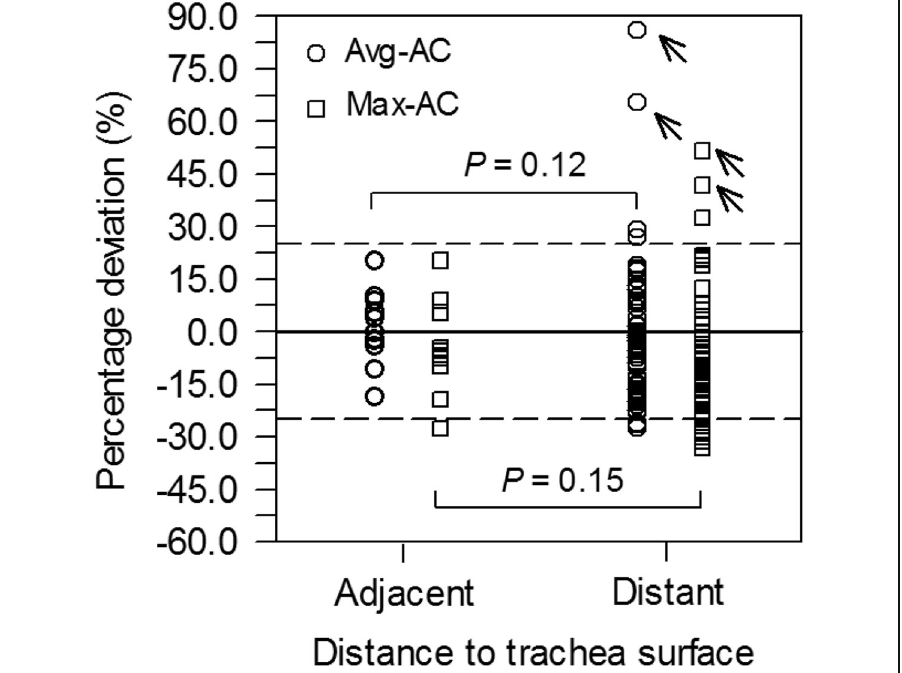
Fig. 3 Percentage deviation between MR-based and CT-based ACs for lesions that are adjacent to (distance ≤ 5 mm) or distant from the trachea surface (distance > 5 mm). Outliers are marked with arrows. Solid (dashed) lines represent the zero (± 20%) percentage